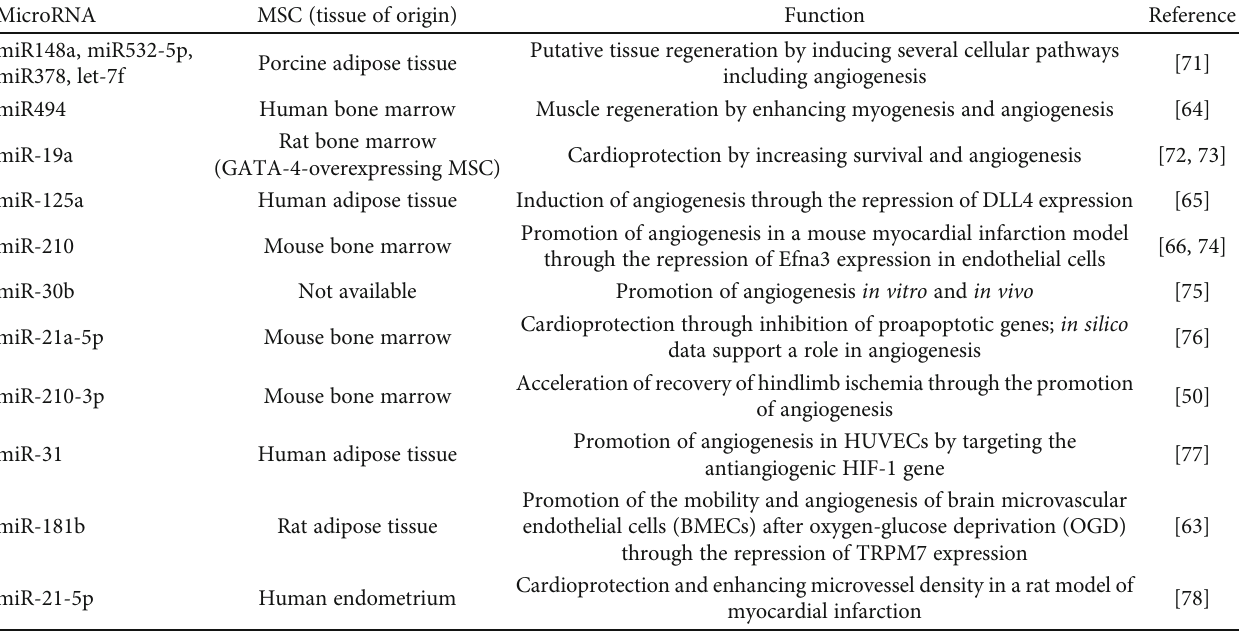
Table 1: Extracellular vesicle miRNA cargo and MSC-mediated